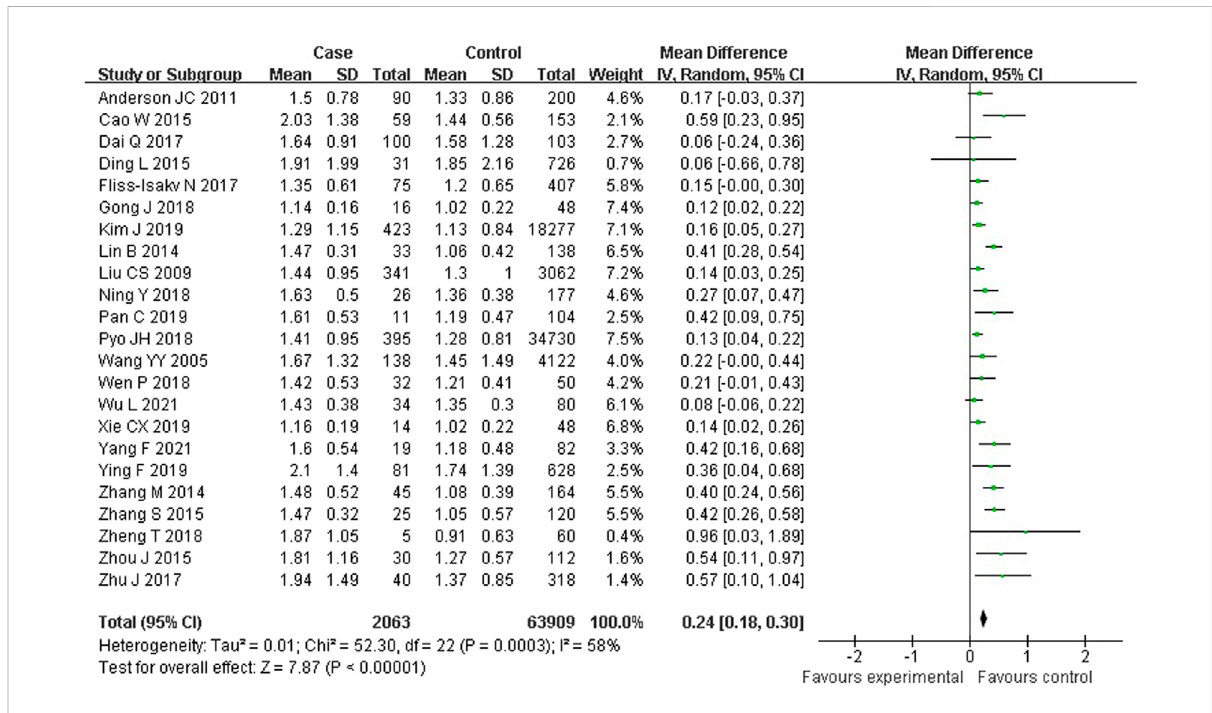
FIGURE 5 Forest plot of meta-analysis for association of serum TG and colorectal serrated lesions.